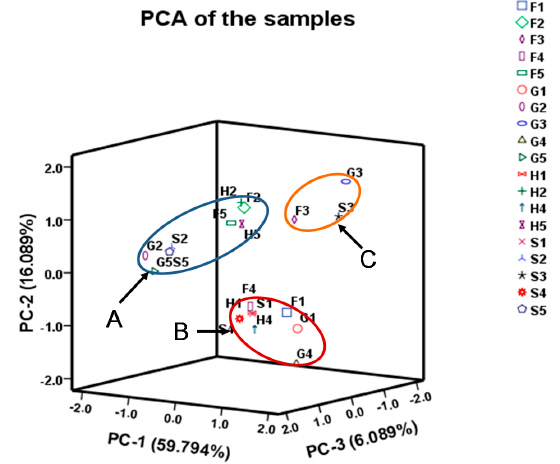
Figure 3. The PCA of the samples. The samples were body wall, ultrasonication ( 1 ), intestine, ultrasonication ( 2 ), coelomic fluid, ultrasonication ( 3 ), body wal, refluxing ( 4 ) and intestine refluxing ( 5 ) collected from Fujian ( F ), Guangxi ( G ), Hong Kong ( H ) and Shandong ( S ).